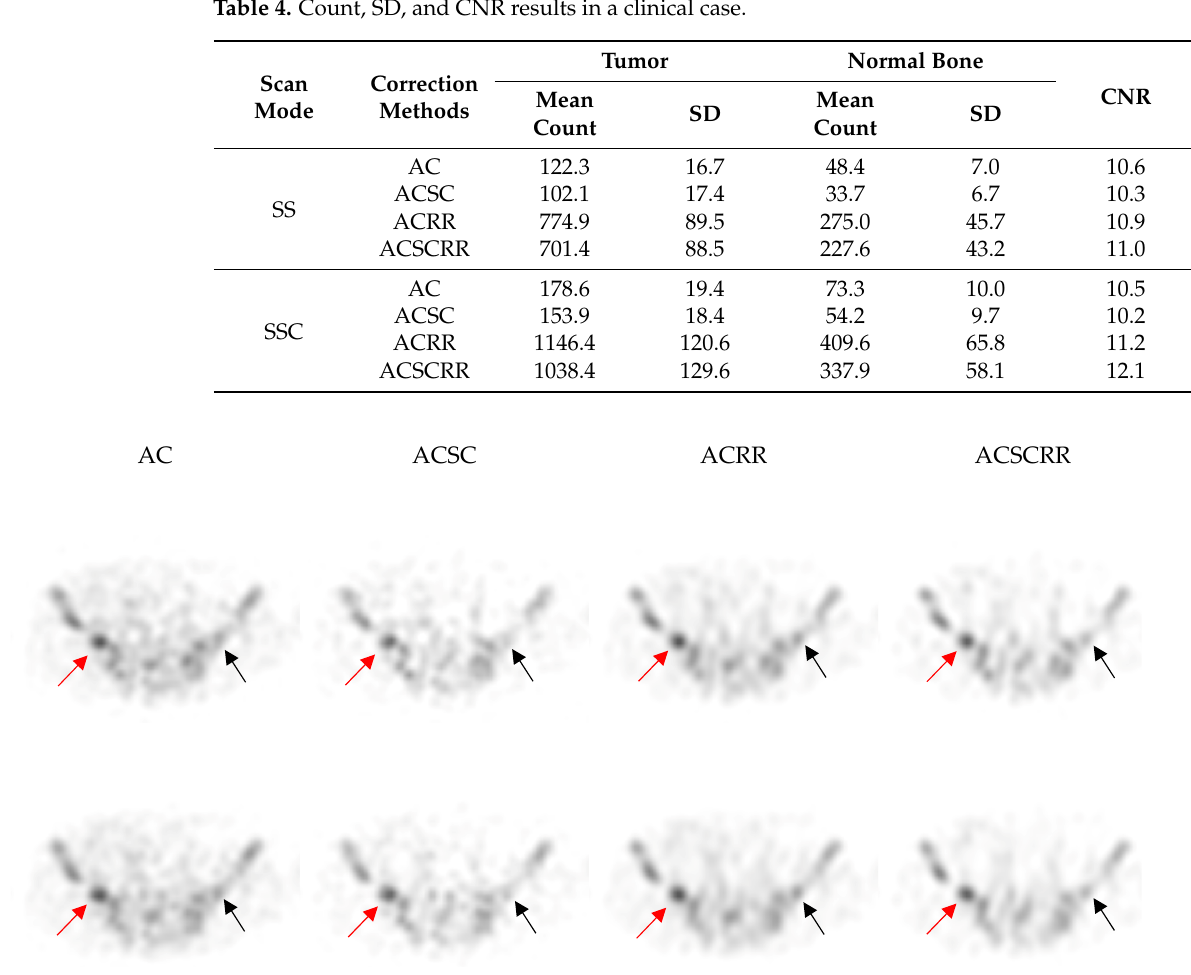
Figure 6. Bone SPECT image for each scan mode and correction methods. The upper and lower window levels were set to 30% and 0%, respectively. The red and black arrows represent the tumor and normal bone regions, respectively.